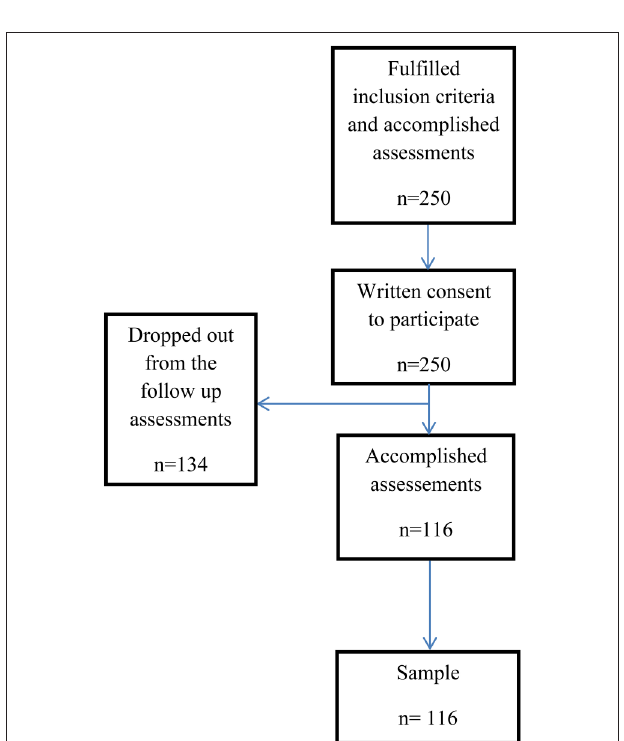
FIGURE 1 | Sample recruitment.